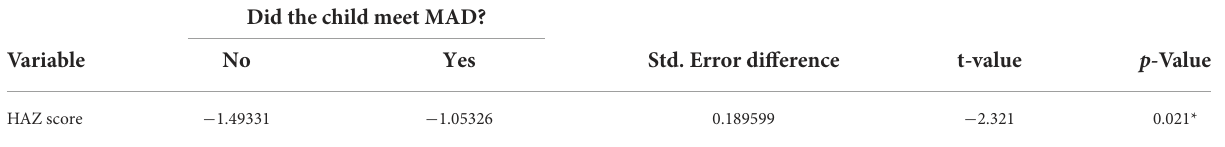
TABLE 6 Independent t -test between HAZ score and MAD.